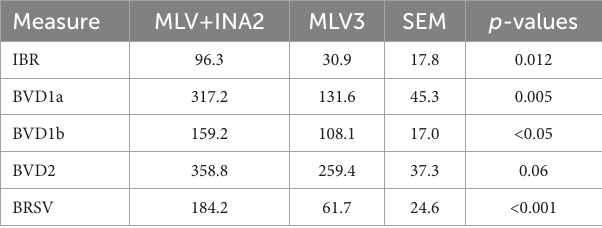
TABLE 2 Main effects of vaccine treatment on mean serum neutralizing antibody titers. 1,2,3